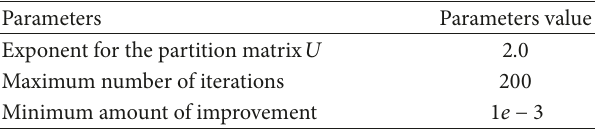
Table 6: FCM clustering algorithm